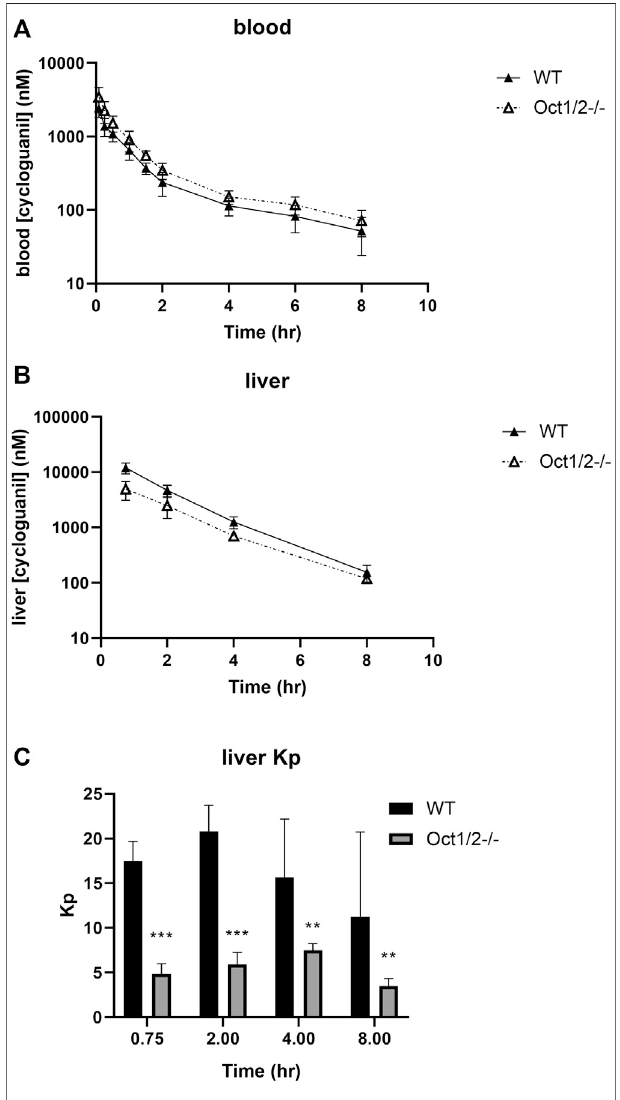
FIGURE 4 | Pharmacokinetics of cycloguanil in wildtype (WT) and Oct1/2 − / − mice following IV administration of cycloguanil . Shown are blood (A) and liver (B) concentrations for mice ( n (cid:2) 5 or 4 – 5/timepoint) administered cycloguanil 2 mg/kg. Filled symbols represent wildtype mice and open symbols represent knockout mice (C) Tissues were collected at 0.75, 2-, 4- and 8 h post-dose. Data presented as mean ± SD. ** p < 0.01 using student ’ s t-test, compared to WT. *** p < 0.001 using student ’ s t-test, compared to WT. Kp (cid:2) tissue:plasma partition coef fi cient.